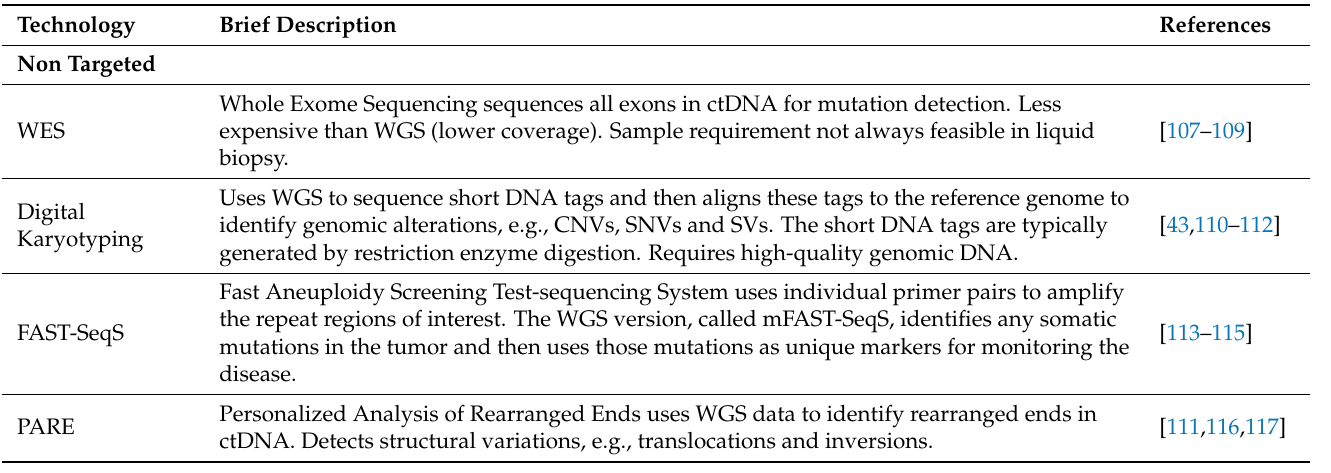
Table 1. NGS platforms designed for biomarkers in liquid